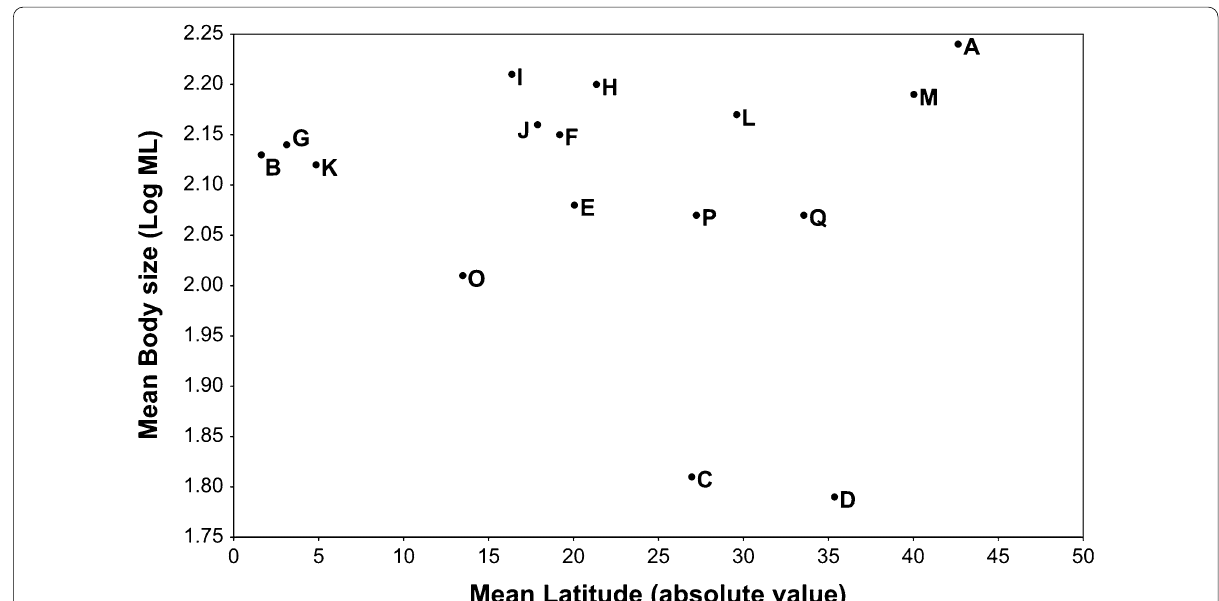
Fig. 7 Relationship between the mean latitude of biogeographical units and mean body size (Log ML) of present species in each